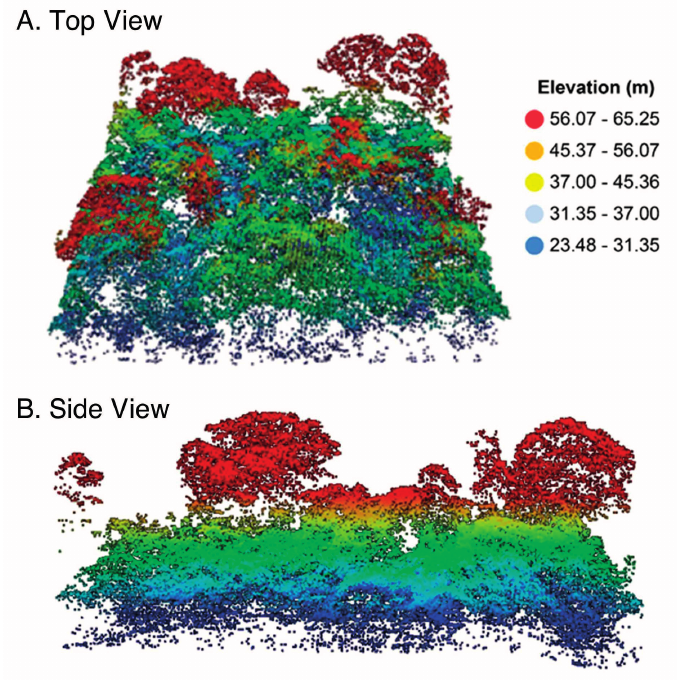
Figure 3. ( A ) Top view and ( B ) Side view of LiDAR point cloud-based 3D structure of forest